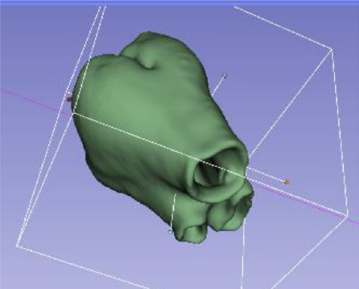
Fig. 3. Extracted digital model after numeric post treatment before 3D